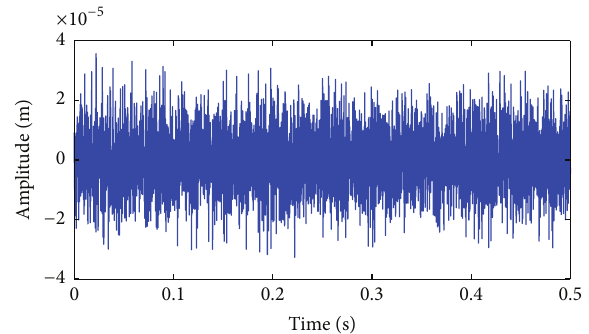
Figure 3: Vibration data of the damaged bearing.